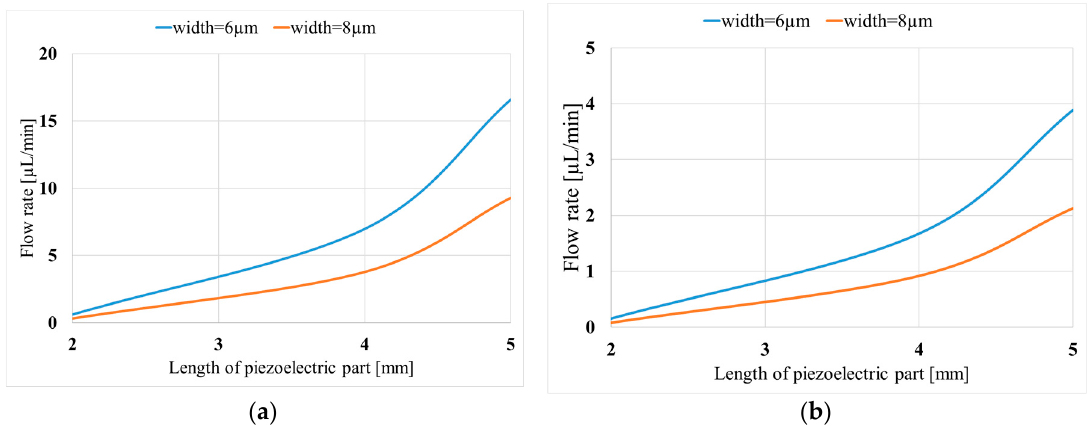
Figure 11. Variation of the obtained flow rate with piezoelectric component length (Lp) for two valve widths (w); ( a ) ( V = 400 V and h p = 130 μ m); ( b ) ( V = 200 V and h p = 130 μ m).